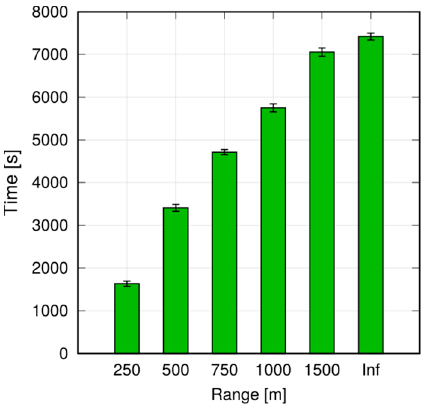
Figure 30. Simulation time.